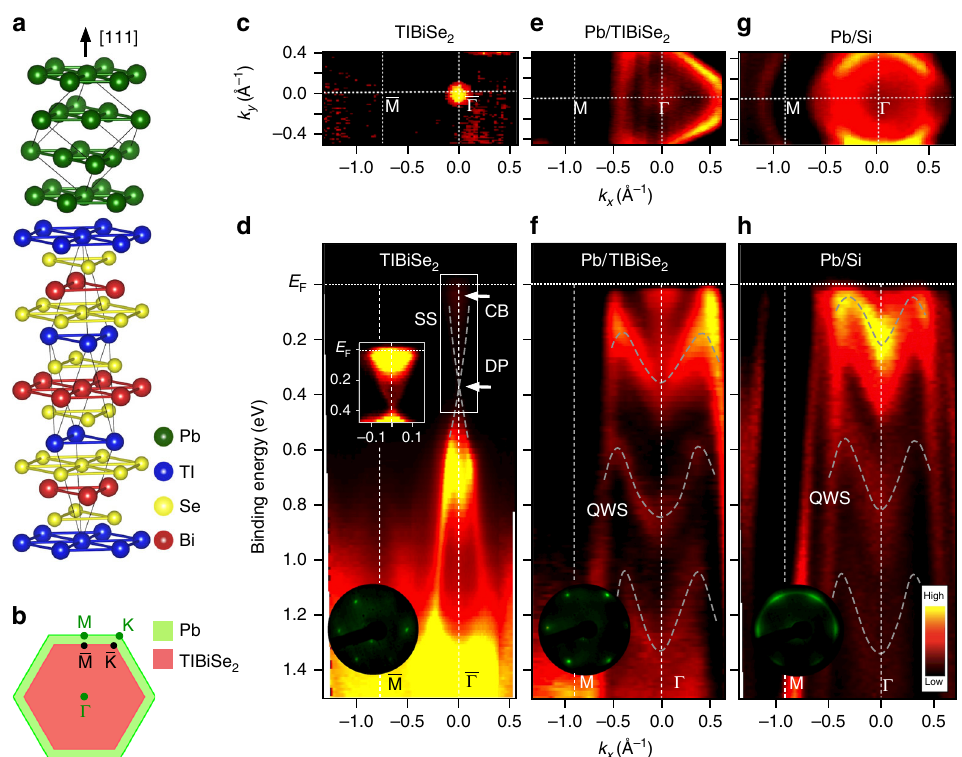
Fig. 1 Crystal and electronic structures of Pb(111) thin fi lm on TlBiSe 2 . a Heterostructure consisting of Pb and TlBiSe 2 . b Comparison of Brillouin zone between TlBiSe 2 (red) and Pb (green). c Plot of ARPES intensity at E F as a function of in-plane wave vector (namely, Fermi surface) around the Γ M line for pristine TlBiSe 2 , measured with the He-I α line ( h ν = 21.218 eV). d ARPES-derived band structure along the Γ M cut for pristine TlBiSe 2 . Inset shows the ARPES intensity with enhanced color contrast in the area enclosed by white rectangle. e , f Same as c and d but for 17ML-Pb/TlBiSe 2 . g , h Same as e and f but for 17ML-Pb/Si(111). SS, CB, DP, and QWS denote the surface state, conduction band, Dirac point, and quantum well state, respectively. Arrows in d indicate the location of CB and DP. Dashed gray curves are a guide for the eyes to trace the SS and QWSs. Insets to d , f , and h are the LEED patterns of the respective fi